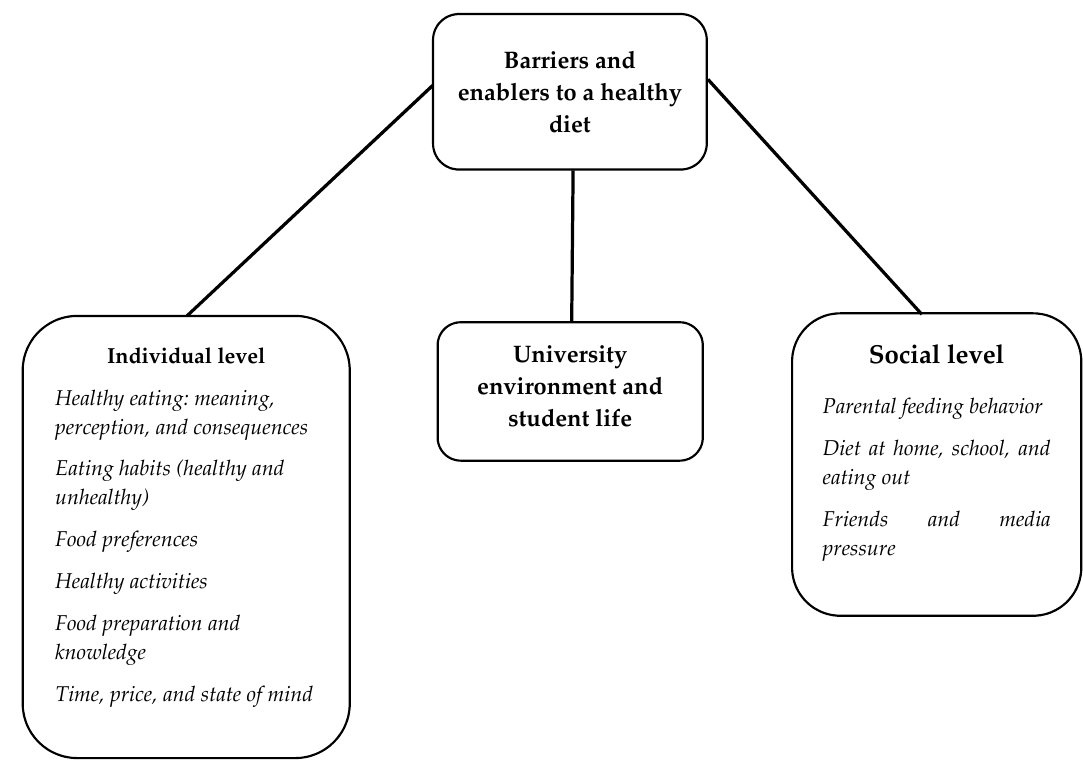
Figure 1. Factors influencing healthy eating behaviors of college